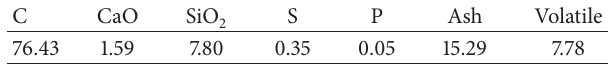
Table 3: The composition of anthracite (%).